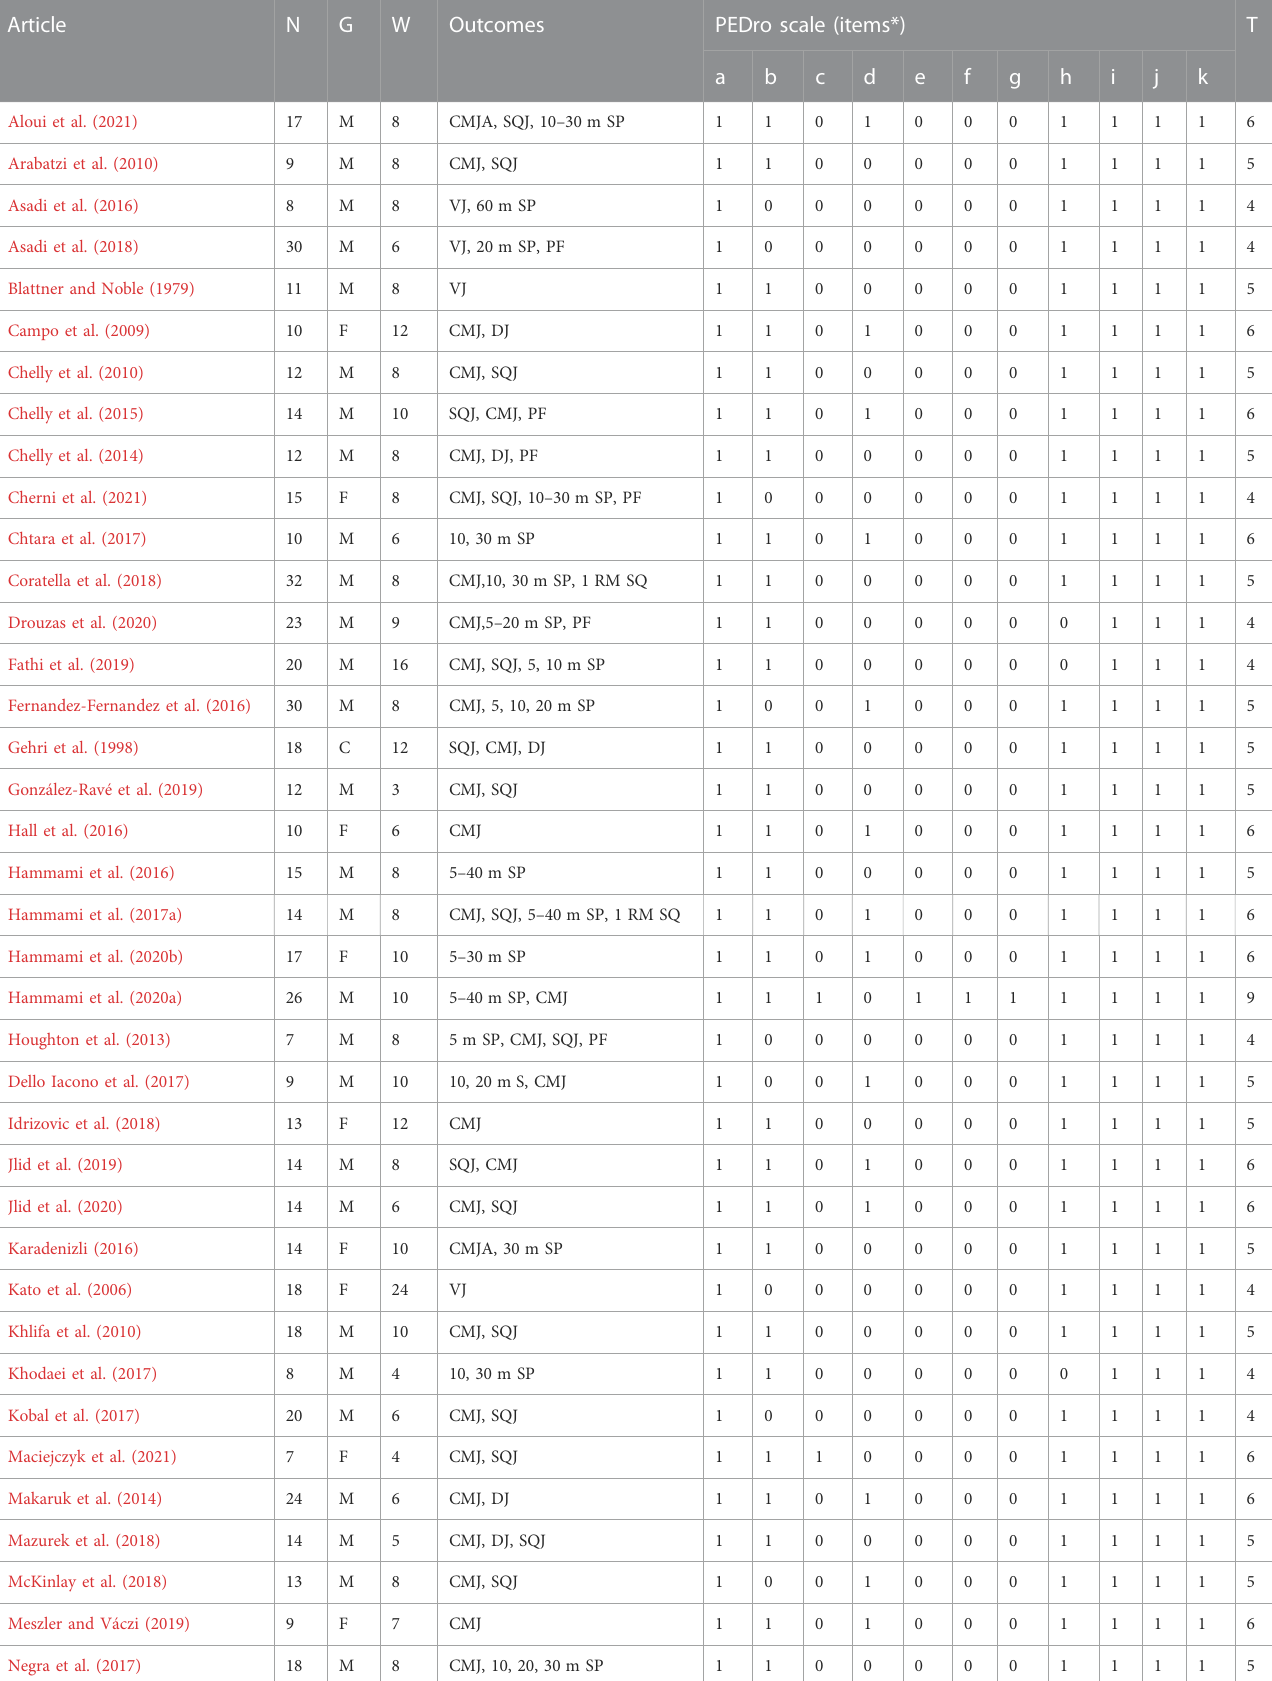
TABLE 1 Characteristics of analyzed PLT studies and PEDro